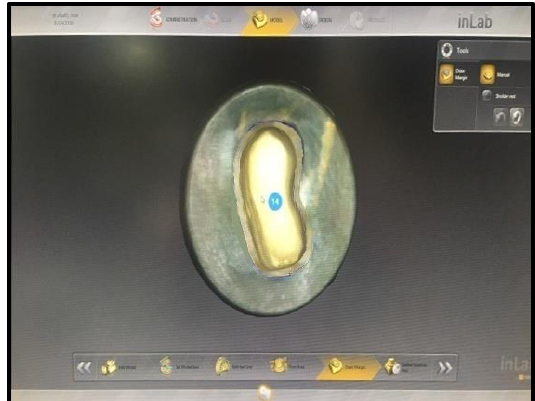
Figure 3: Scanning of teeth using omnicam